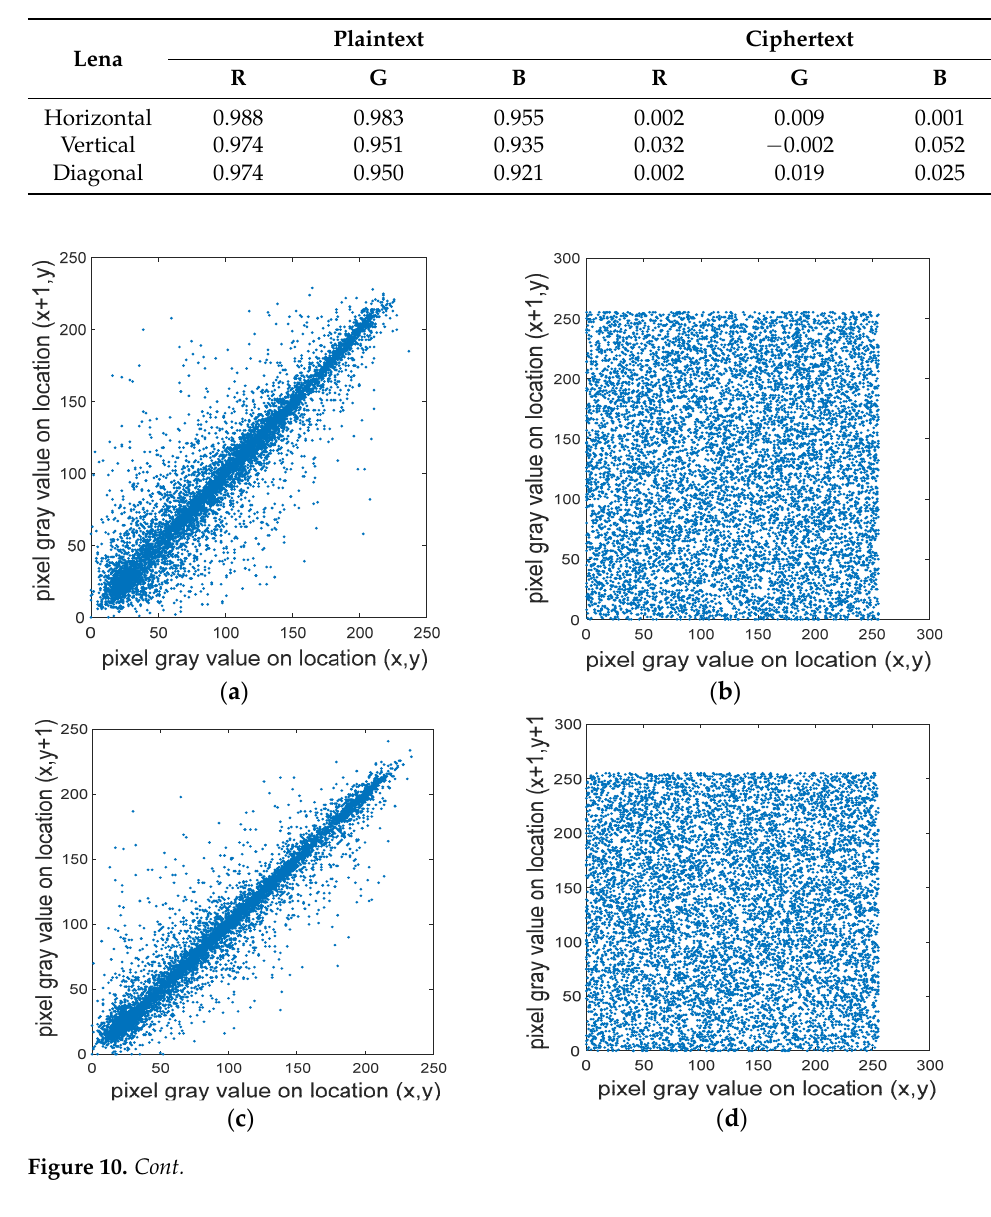
Table 2. Correlation between adjacent pixels of plaintext and ciphertext images.